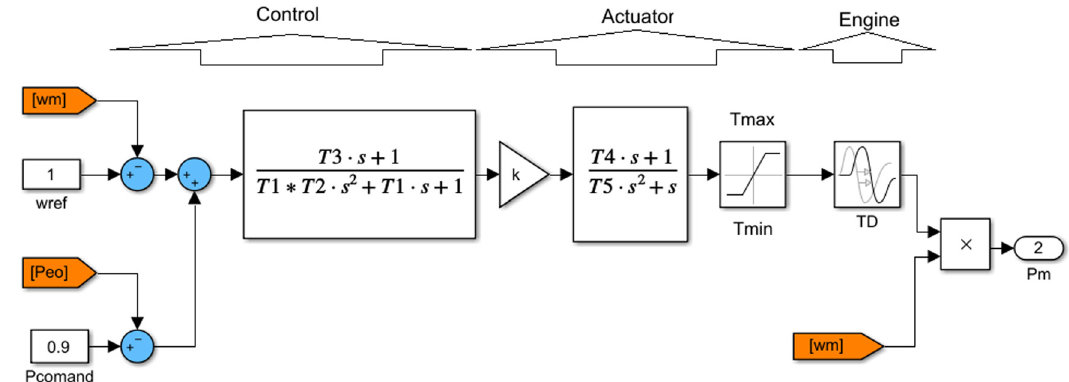
Figure 9: Speed control of the synchronous